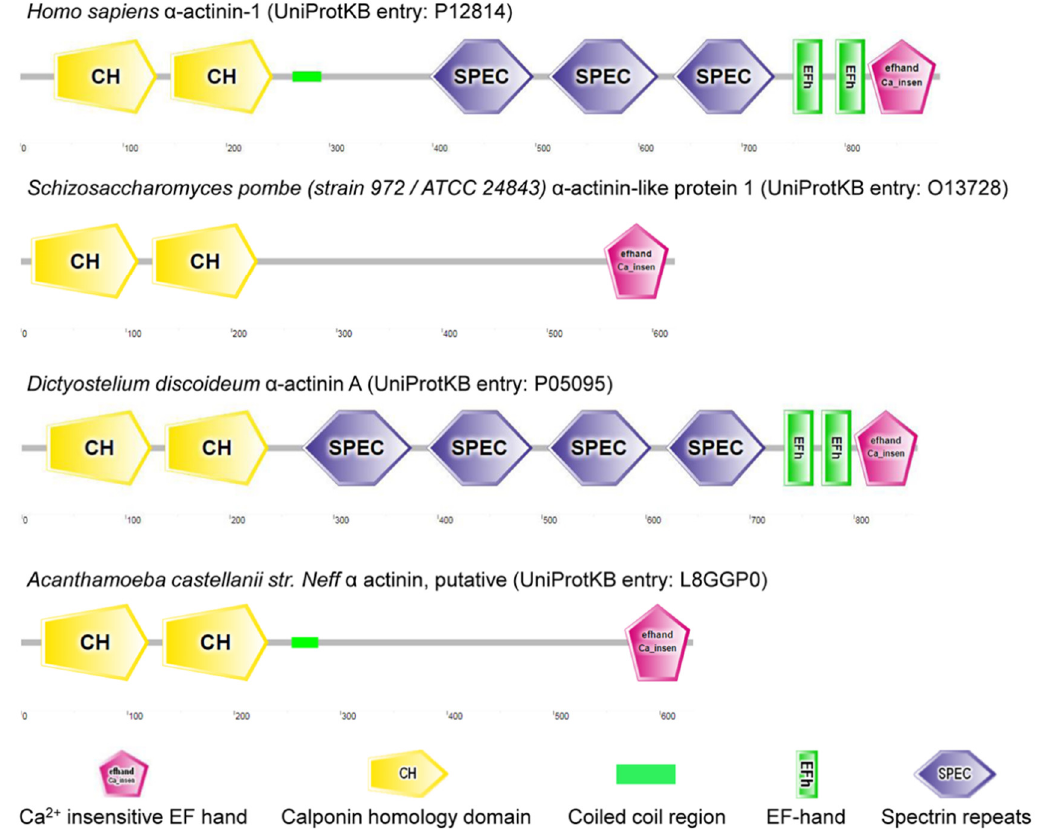
Figure 2. α-actinin homologs in Homo sapiens , Schizosaccharomyces pombe , Dictyostelium discoideum and Acanthamoeba castellanii str. Neff .